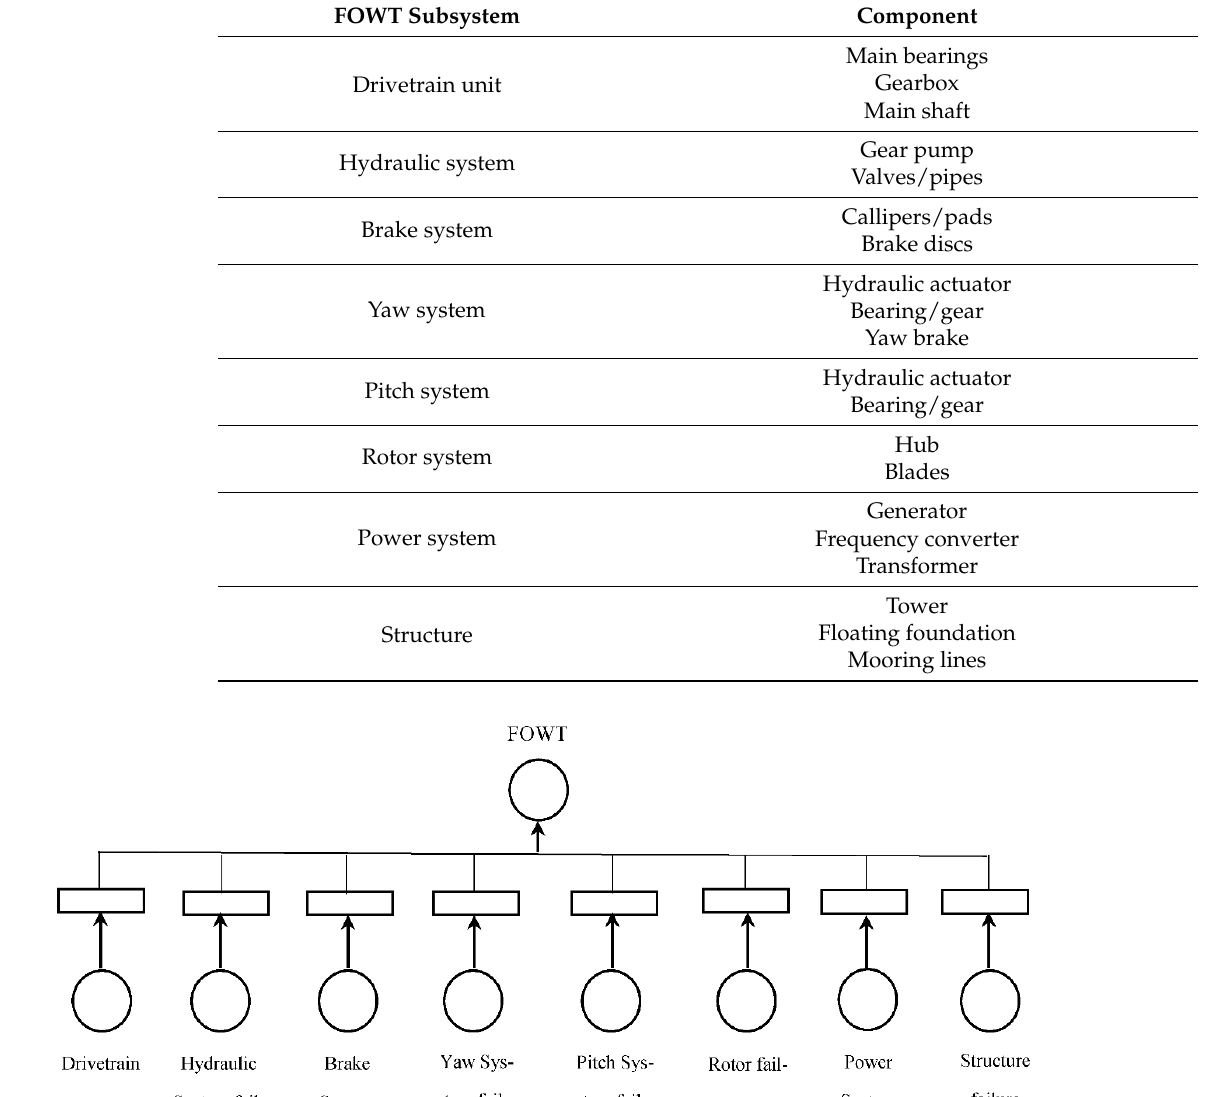
Figure 4. Petri network model for FOWT system failure.